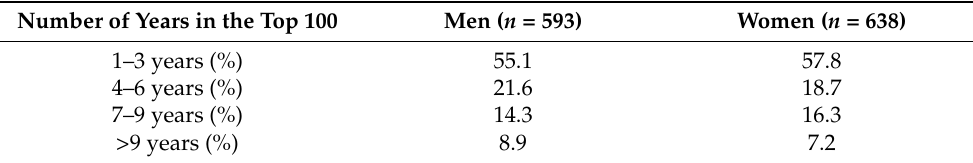
Table 2. Distribution of the number of years remaining in the World Ranking top 100 badminton